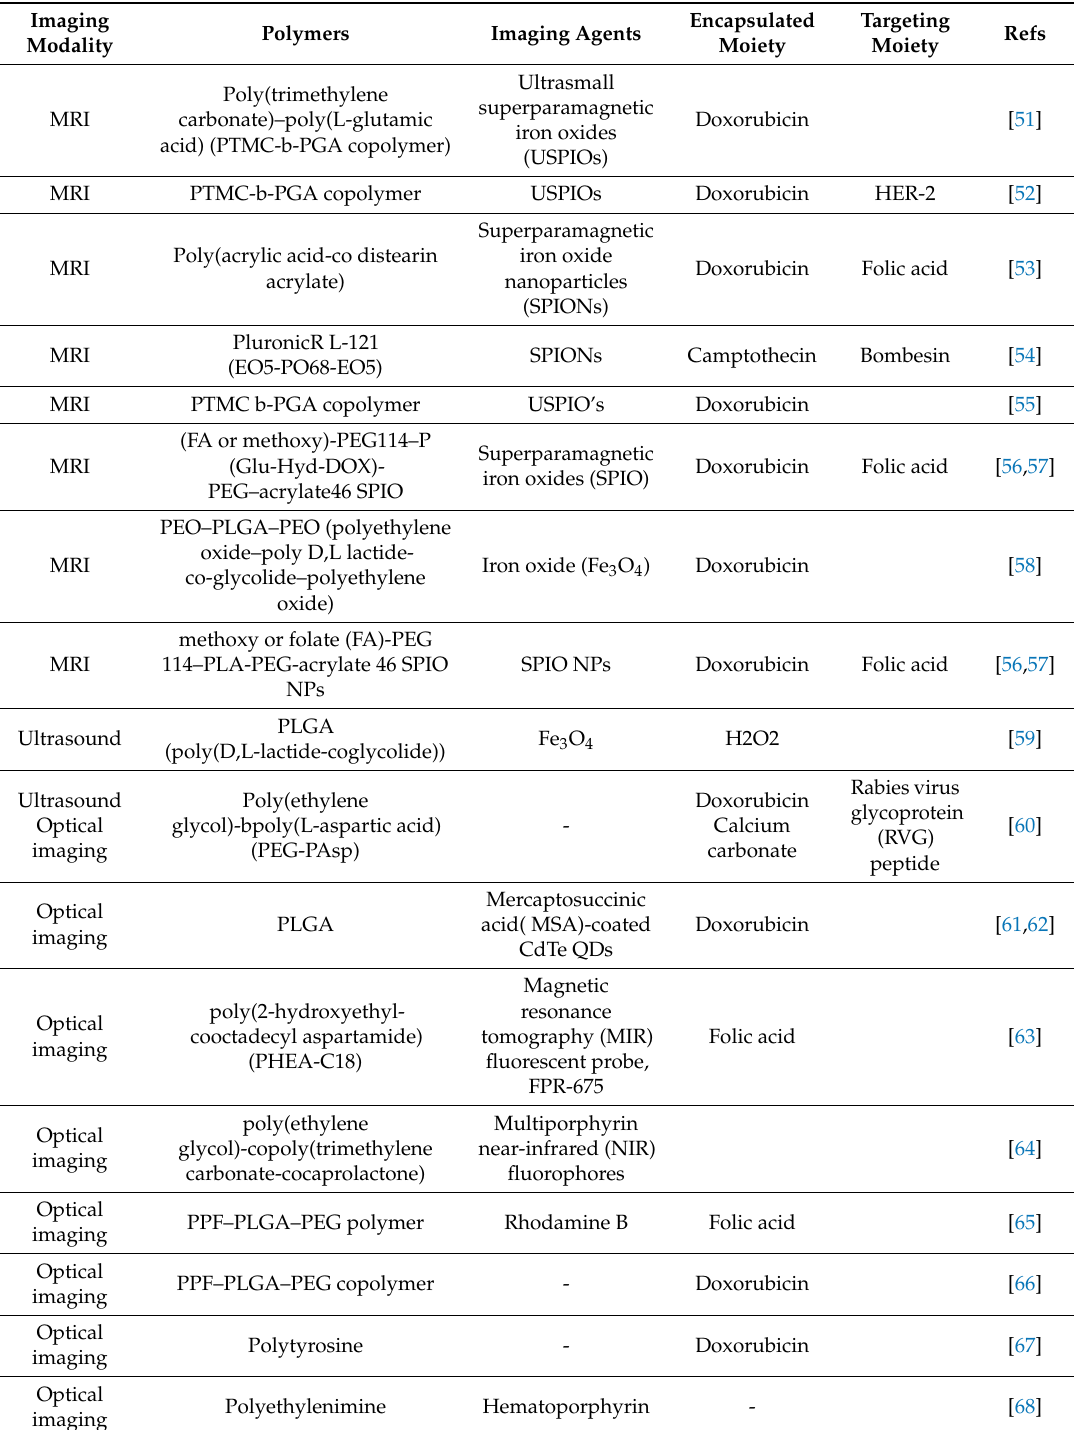
Table 1. The biocompatible polymer-based cancer